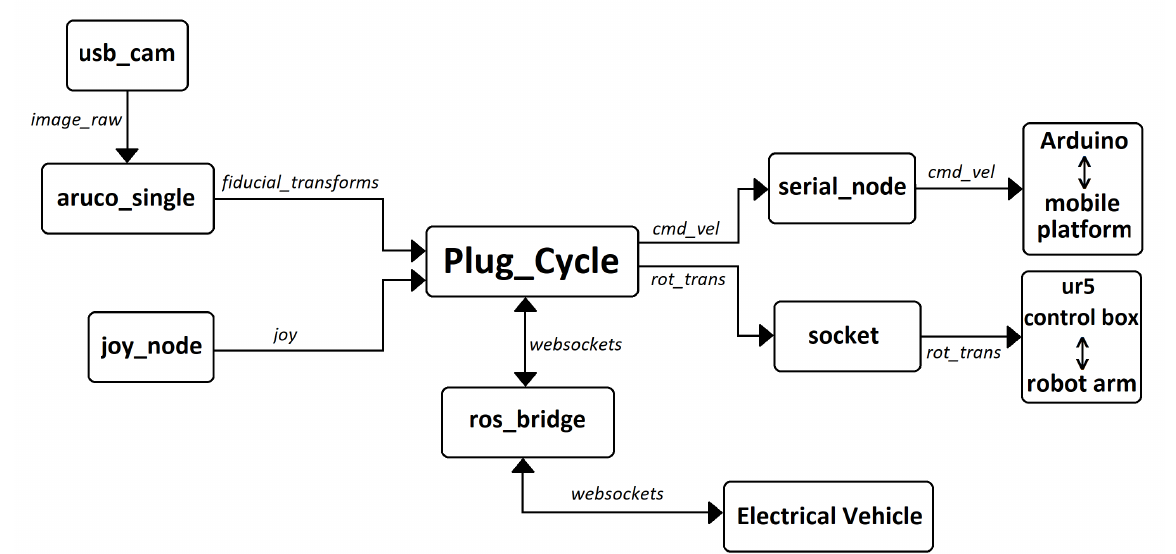
Figure 3. Global software architecture of the Autonomous Charging Station.